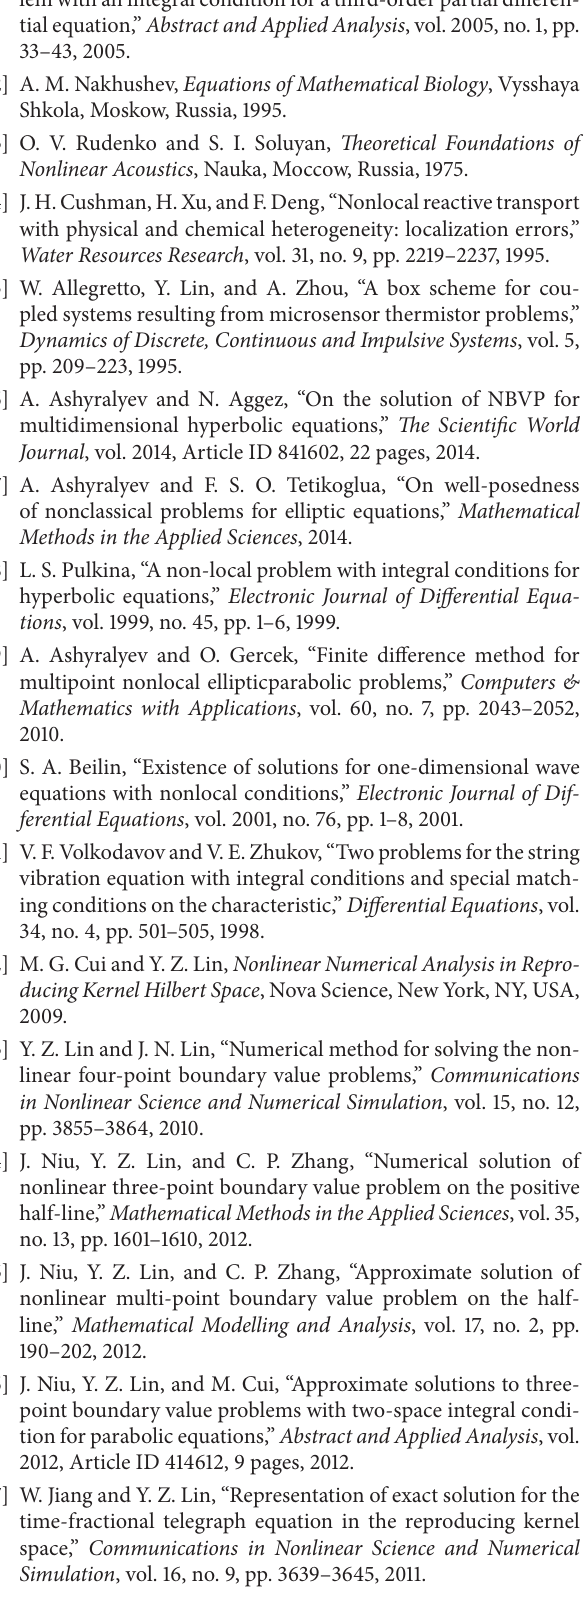
Table 2: Maximum absolute error for Example 12. Method 𝑚 = 30 𝑚 = 60 𝑚 = 90 Finite difference in [9] 0.015167 0.007318 0.004822 Finite difference in [9] 0.000908 0.000227